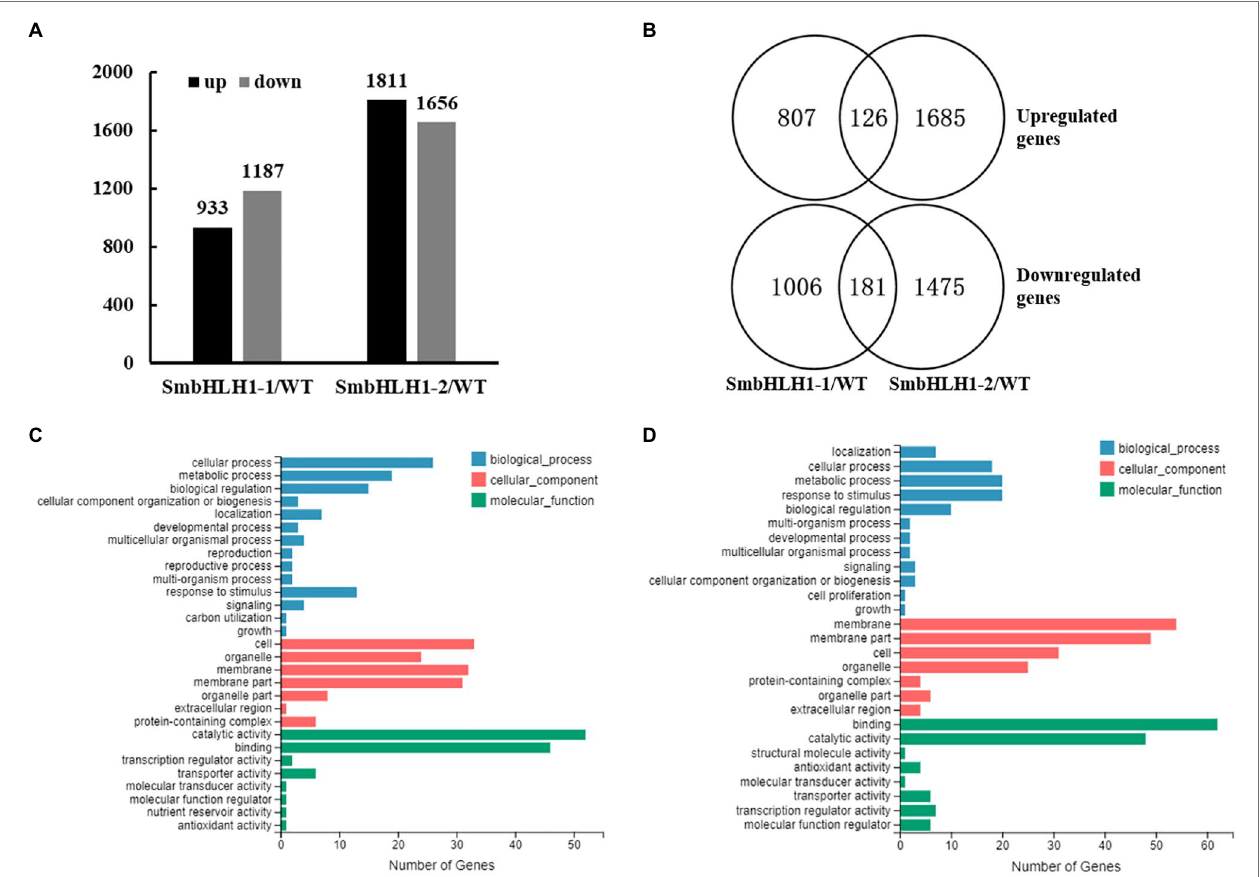
FIGURE 6 | Overview, Venn diagrams and GO enrichment analysis of up- or downregulated genes by SmbHLH1 in stems at a level |log 2ratio | ≥ 0.5 with p < 0.001. (A) Number of upregulated and downregulated genes in the two 35S::SmbHLH1 stem peels lines vs. WT with RNA-seq. (B) Schematic of the Venn diagram analysis of common upregulated and downregulated genes [differentially expressed genes (DEGs)] in the two 35S::SmbHLH1 stem peels lines vs. WT. (C,D) GO functional enrichment analysis of common upregulated (C) and downregulated (D)